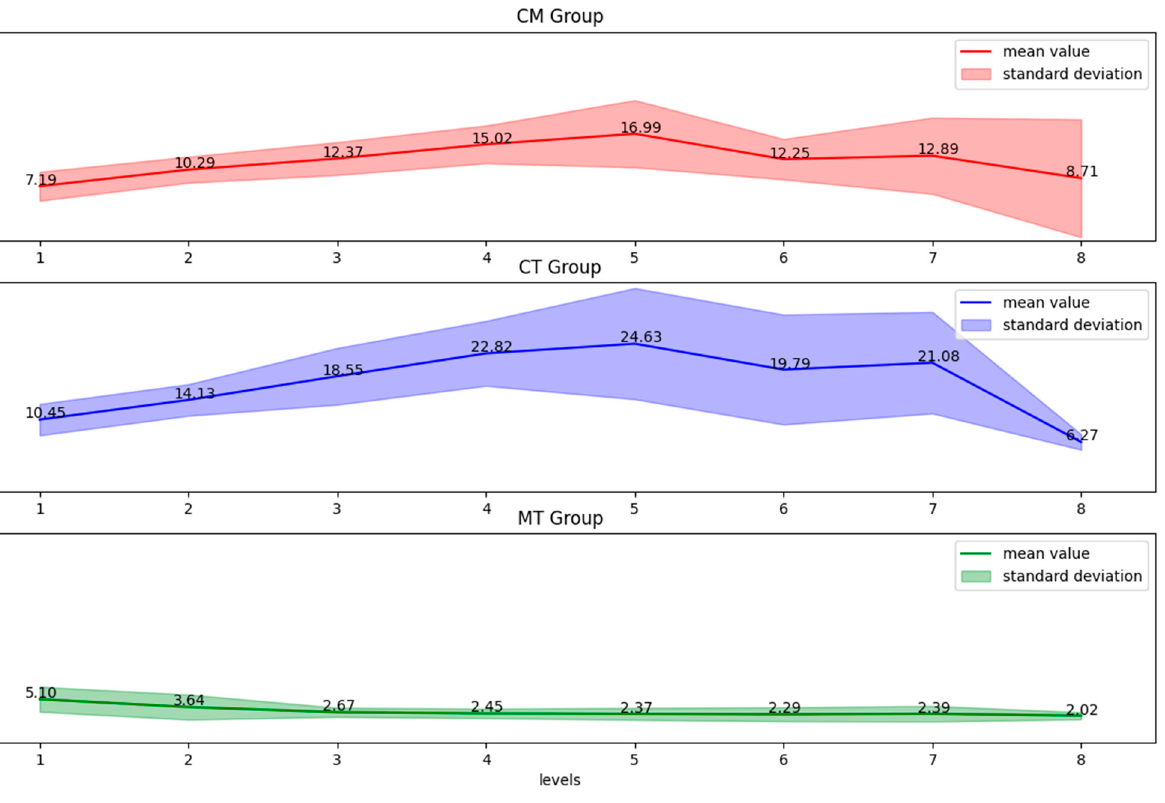
Figure 2. Average orientation and planning time for each difficulty level in all training groups: the top chart—dual-task cognitive-motor group, the middle chart—single training cognitive group, the bottom chart—single training motor group.